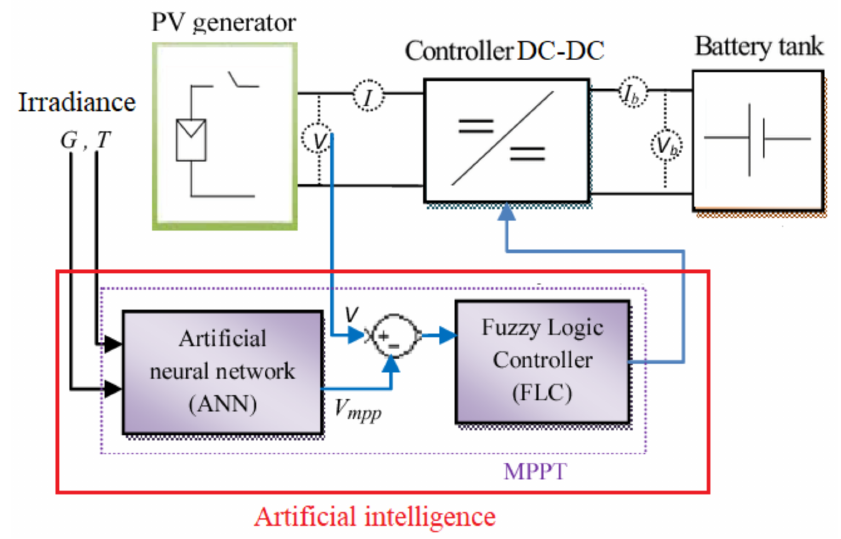
Figure 17. Artificial Intelligence (AI)